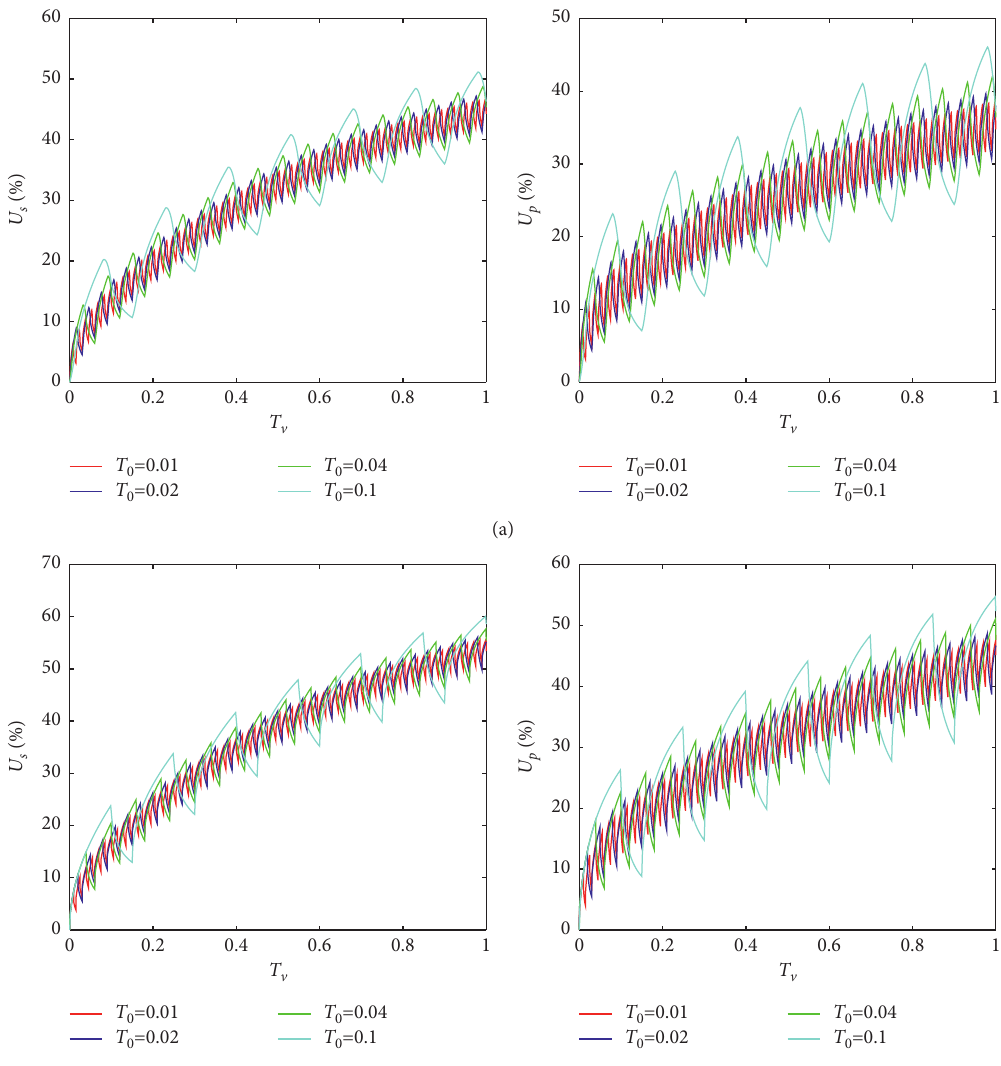
T v under different values of β s and U p with time factor